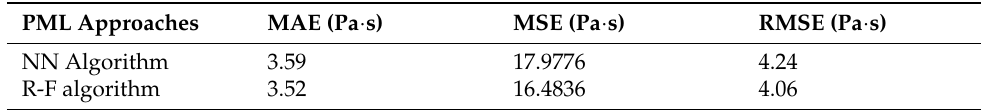
Table 3. Statistical outcomes of plastic viscosity for employed models.